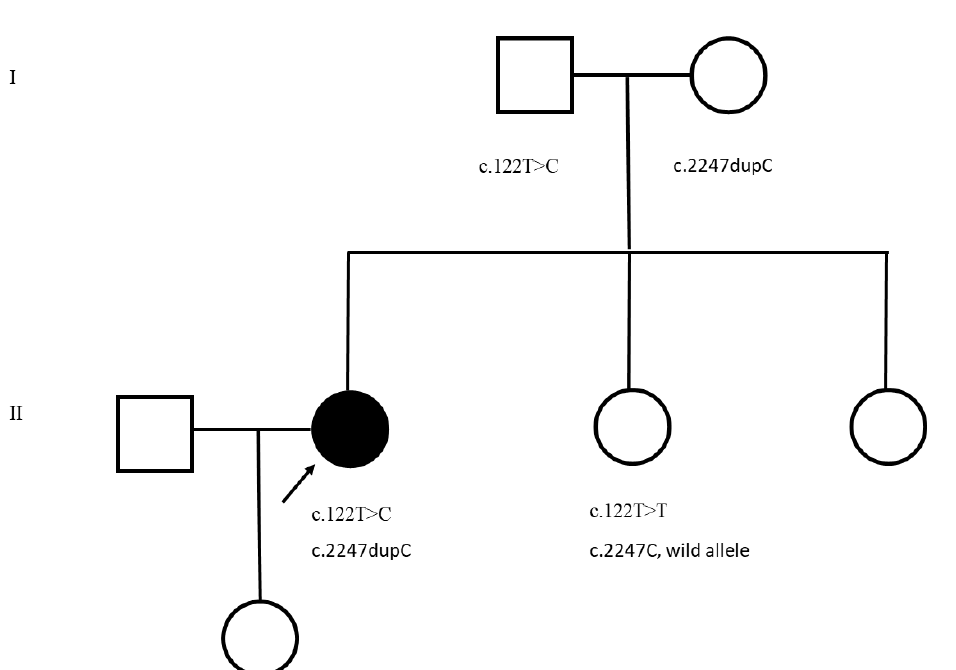
Figure 1. This is the pedigree showing parents each carrying a variant in the FIG4 gene and the affected daughter has inherited both the variants. Squares, males; Circles, females; Dark circle, af- fected